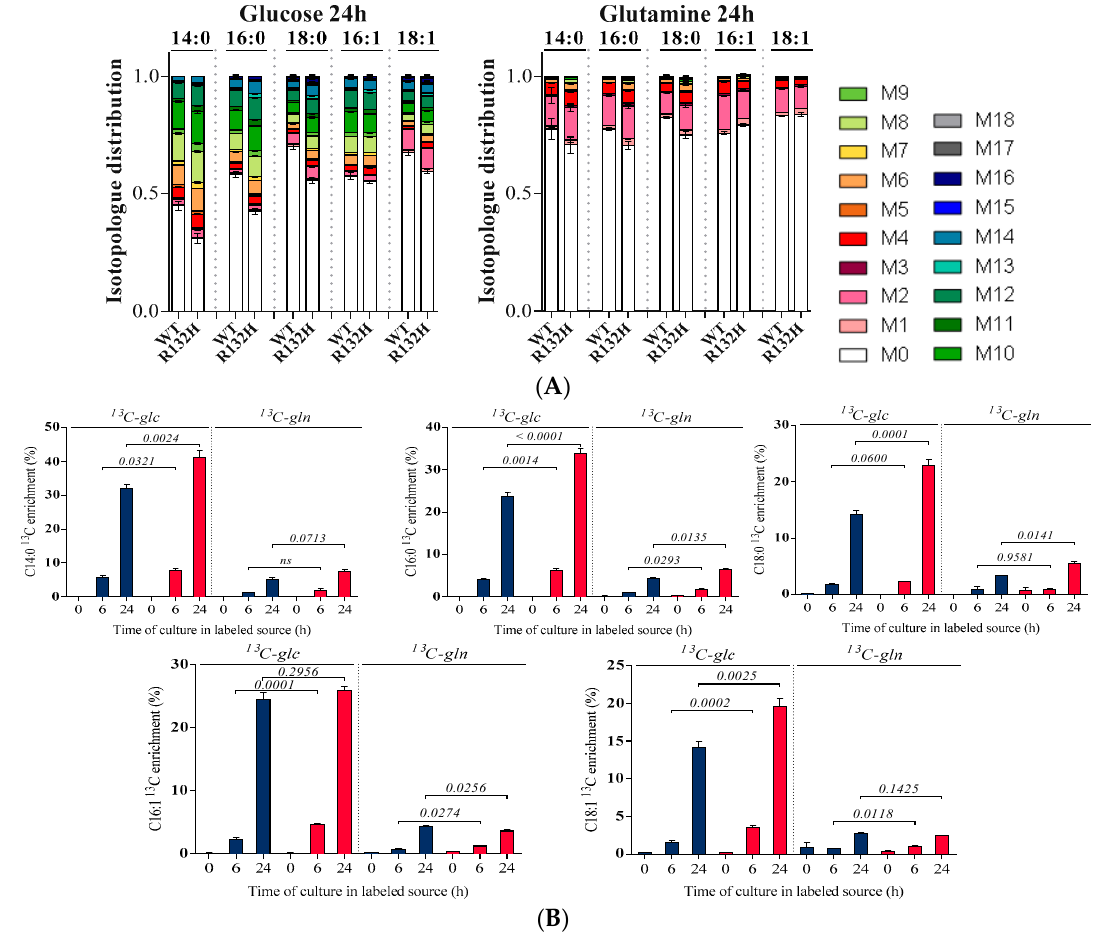
Figure 4. Isotopologues distribution ( A ) in C14:0; C16:0; C18:0; C16:1; and, C18:1 in HL60 IDH1 WT (in blue) and R132H (in red) at 24 h following and ( B ) 13 C enrichment at 0, 6, or 24 h cultures on [U- 13 C]-glucose or [U- 13 C]-glutamine ( n > 2).